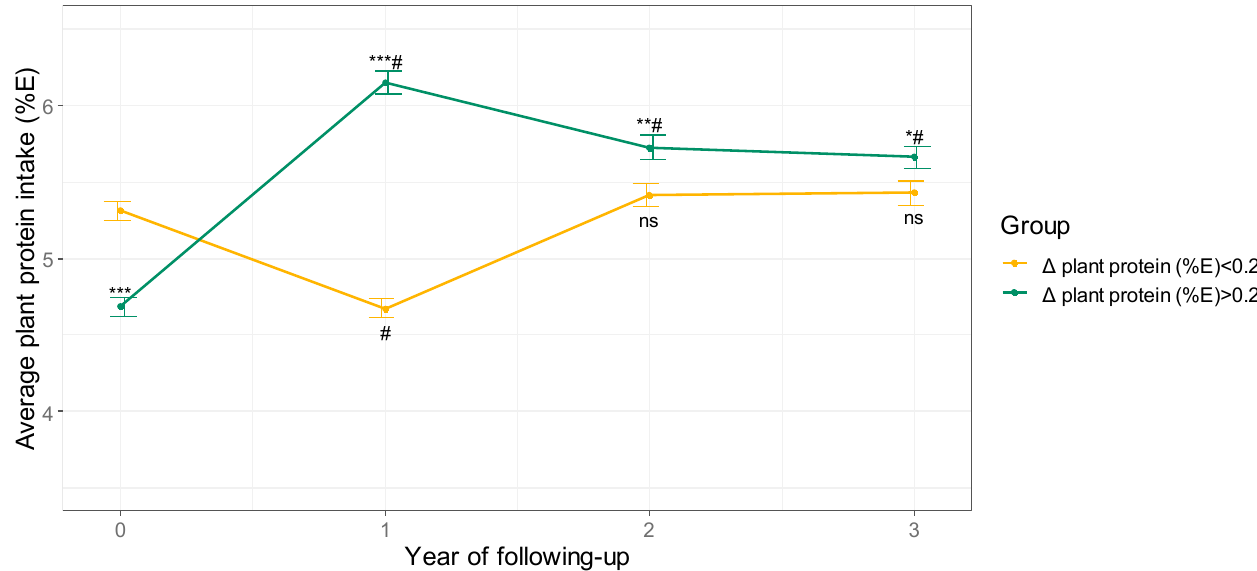
Figure 1. Average plant protein consumption during 3 years of follow-up. Values are expressed as mean ± SEM. *** p < 0.001, ** p < 0.01, and * p < 0.05 for comparisons between groups at each visit. # p < 0.001 for comparisons with baseline in each group. Δ , change; E: energy, ns: not significant.